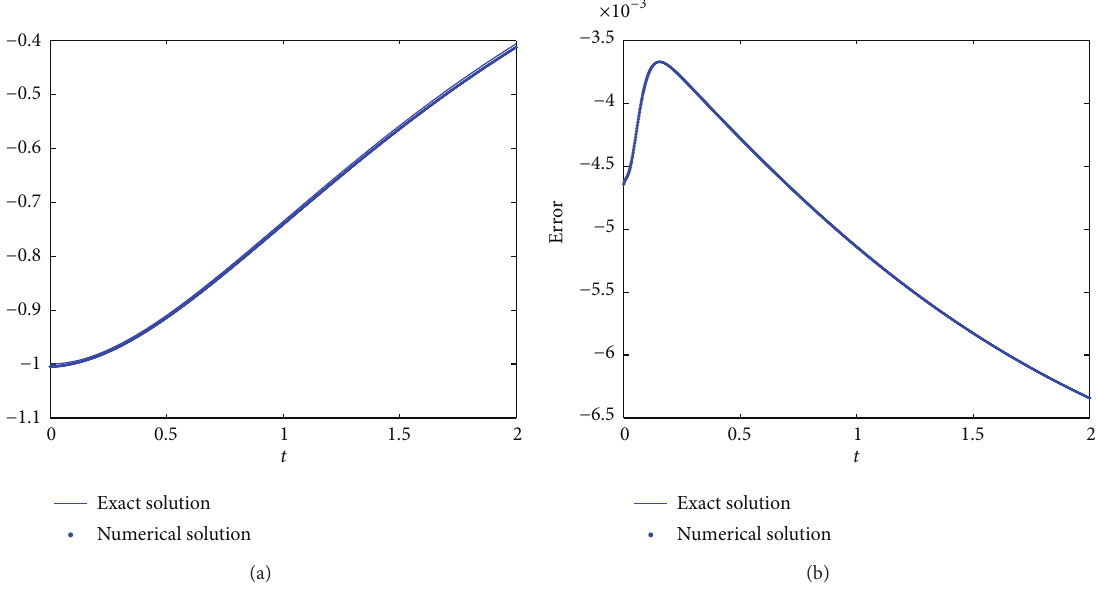
̂𝑓(𝑡) ̂𝑓(𝑡) (a), the error 𝑓(𝑡) − (b) with 𝛾 = 0.001 .